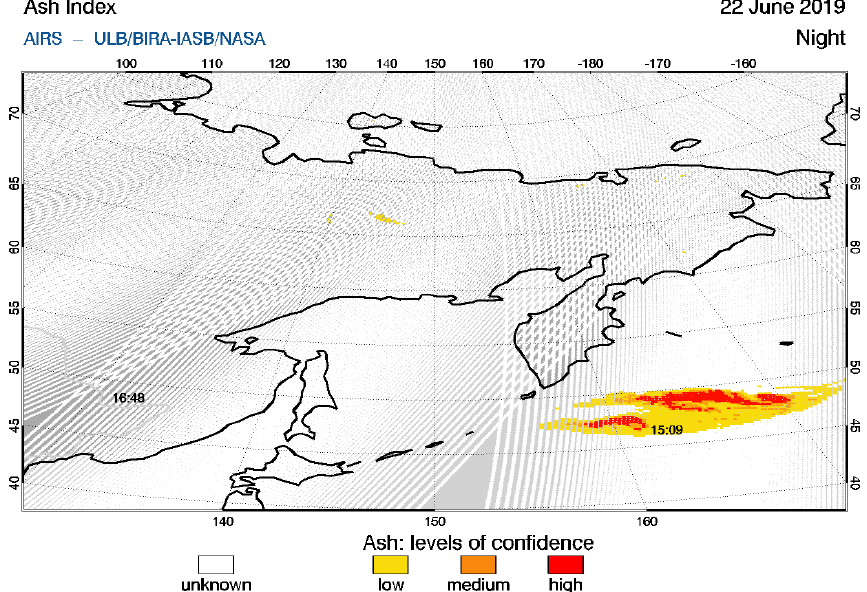
Figure 6. Ash detection from AIRS on 22 June 2019 (Raikoke eruption, Kuril Islands).